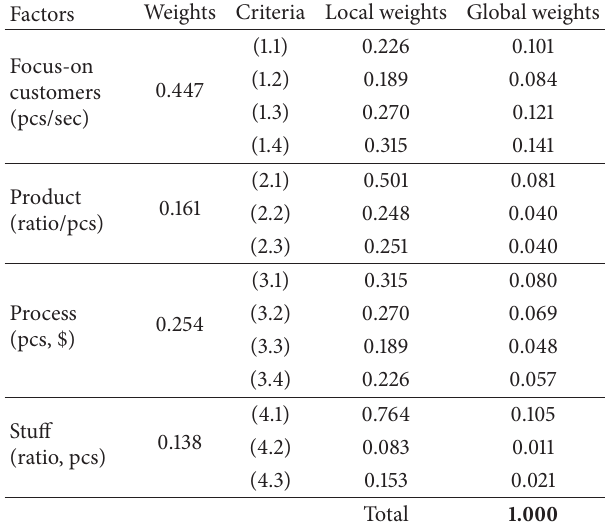
Table 1: Linguistic variables for the important weight of each criterion.